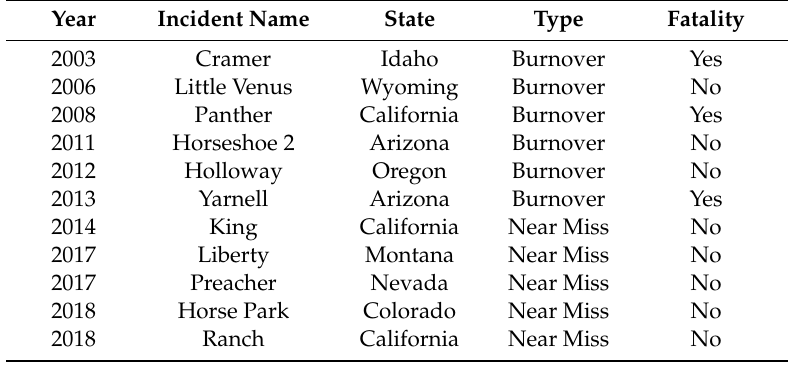
Table 6. Recent wildland firefighter entrapments used as a basis for ERI